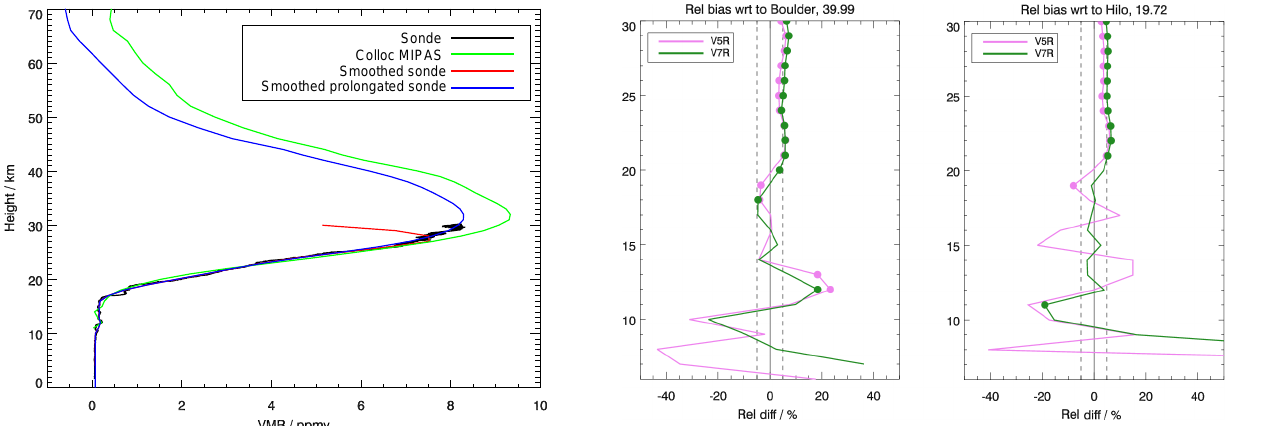
Figure 5. Application of MIPAS AK to the ozonesonde profiles: original ozonesonde profile, collocated MIPAS profile at geoloca- tion 20100630T164035Z, and interpolated, smoothed and prolon- gated ozonesonde profiles .